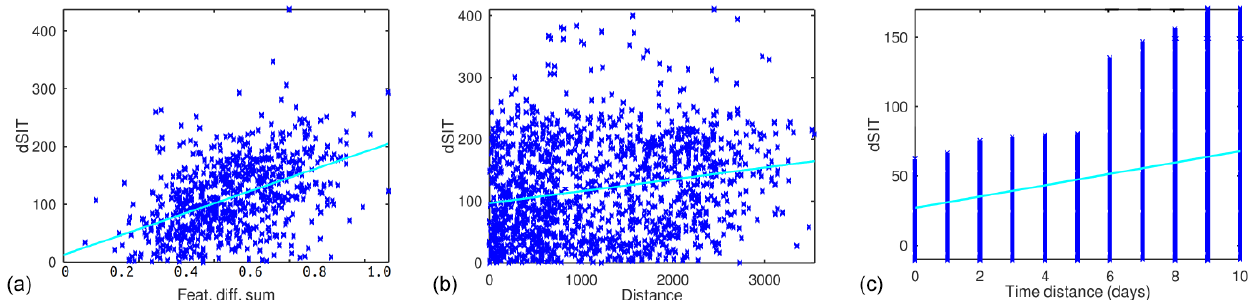
Figure 7. (a) Dependence of the SIT difference on the pairwise SAR segment texture difference, (b) dependence of the SIT difference on the pairwise SAR segment distance and (c) dependence of the SIT difference on the pairwise SAR segment time difference. The cyan lines in the figures represent the linear least-squares regression.